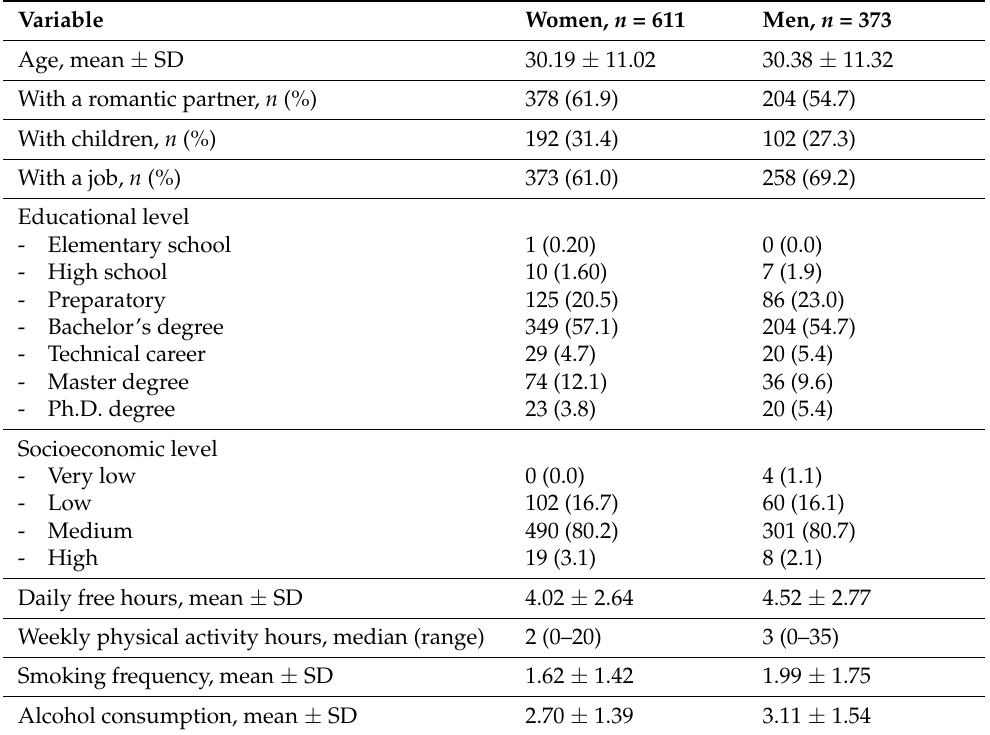
Table 1. Sociodemographic variables in the studied